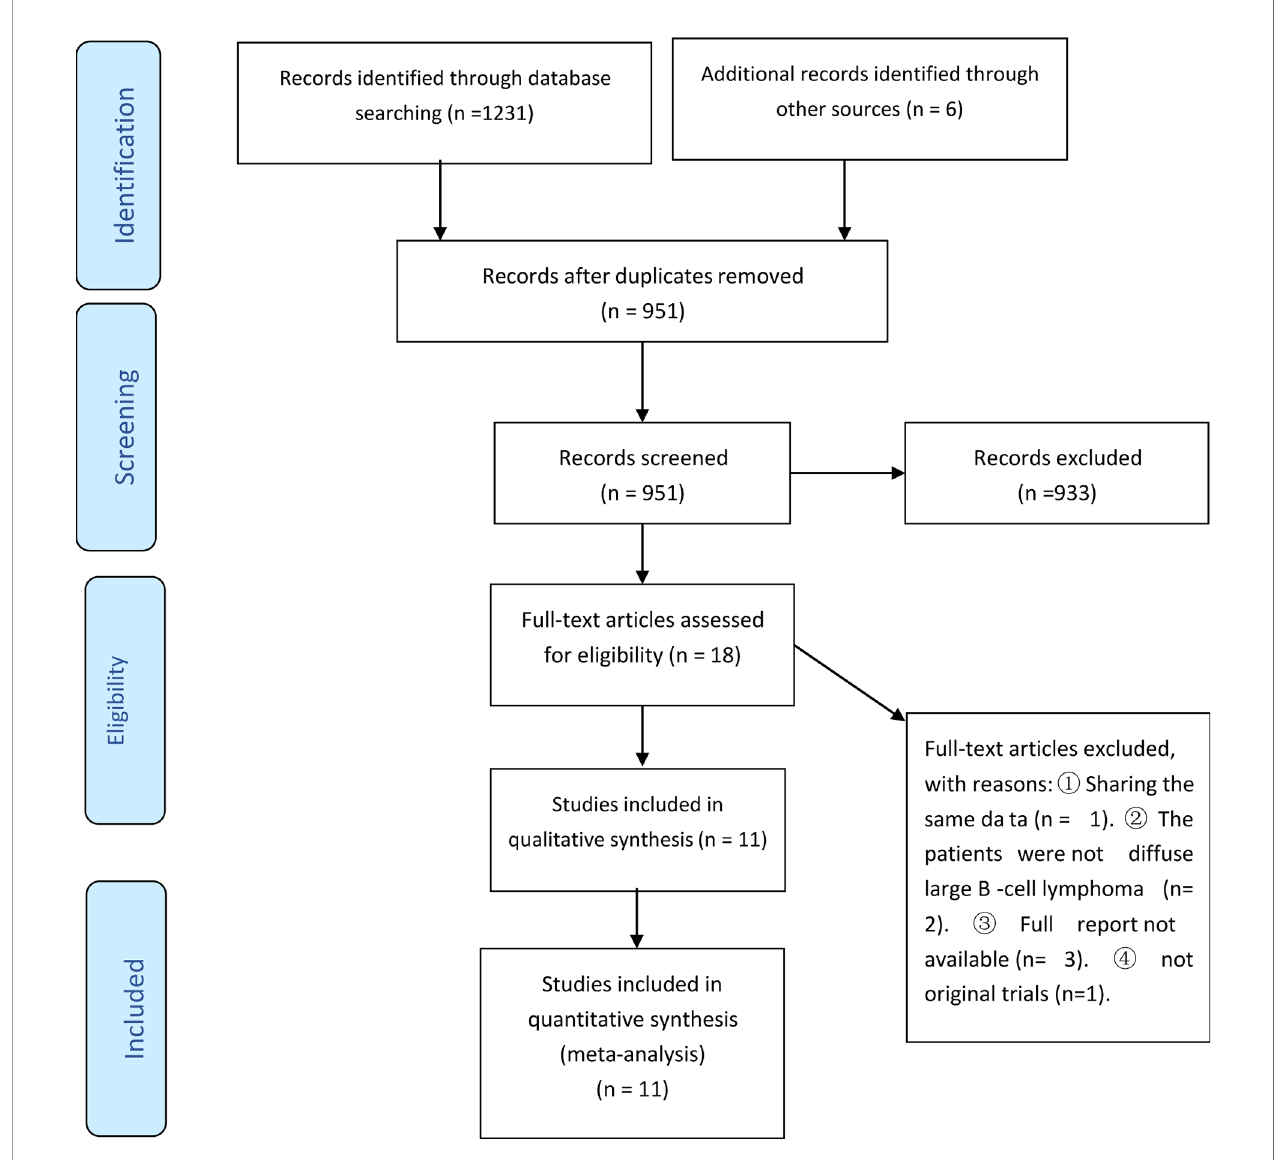
FIGURE 1 | PRISMA fl ow diagram for selection of publications included in the